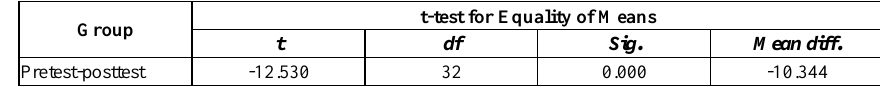
Table 2. The result of